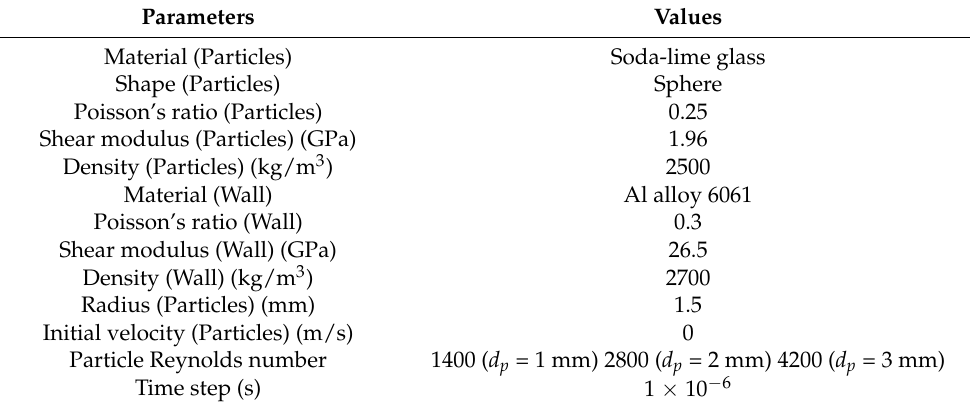
Table 1. Parameters of the solid phase in simulation.